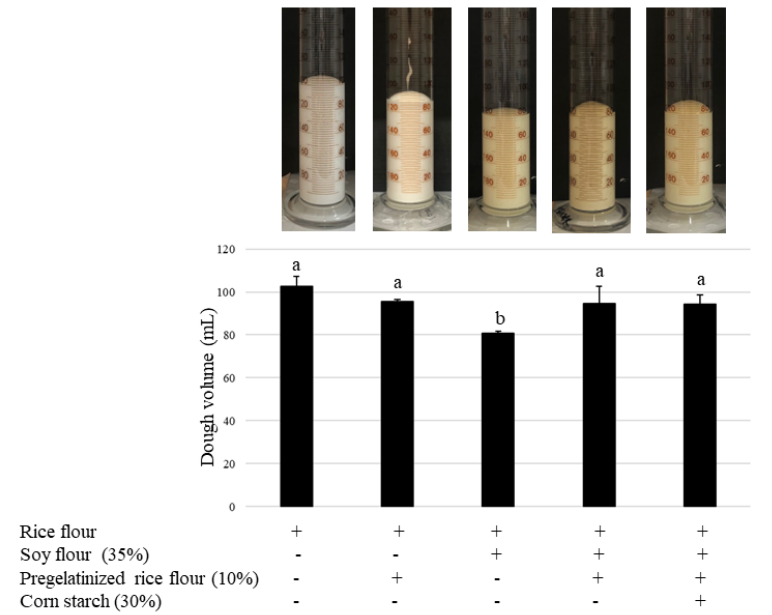
Figure 7. Effect of pregelatinized rice flour and cornstarch on the fermentation process (30 min). Data are shown as mean ± SD. Different letters indicate p < 0.05 between groups.